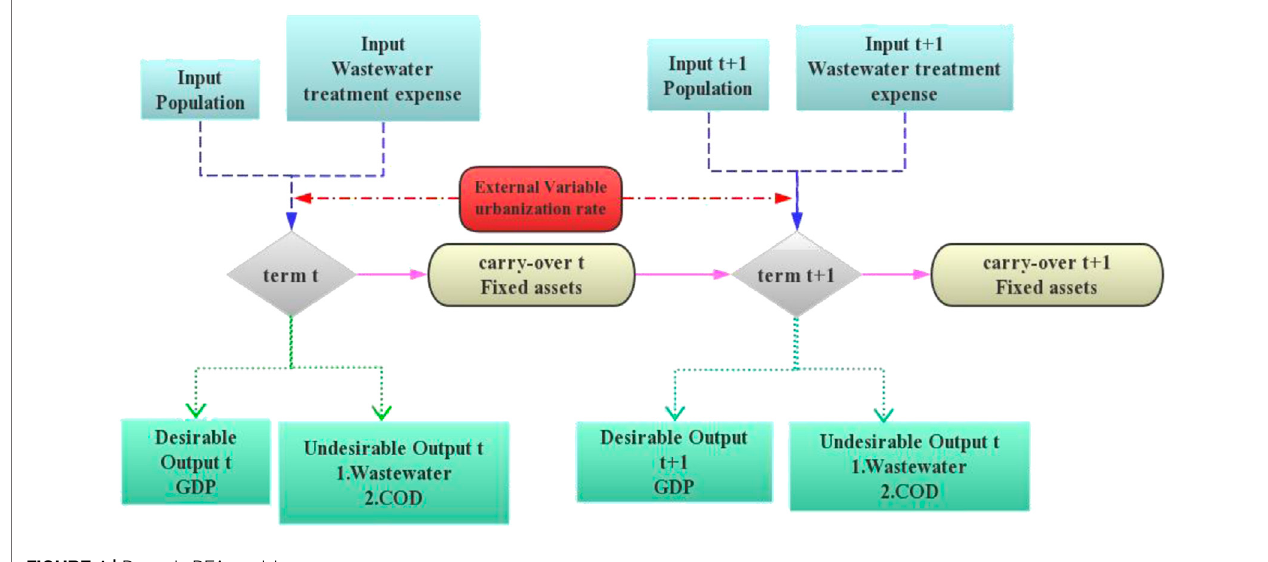
FIGURE 1 | Dynamic DEA model.